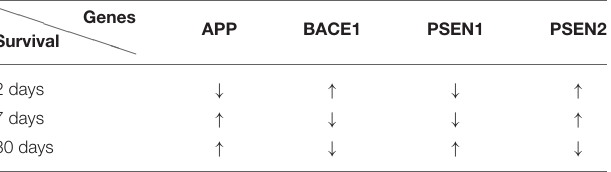
TABLE 3 | Changes in the expression of the Alzheimer’s disease-linked genes in the medial temporal cortex at various times after experimental ischemic brain